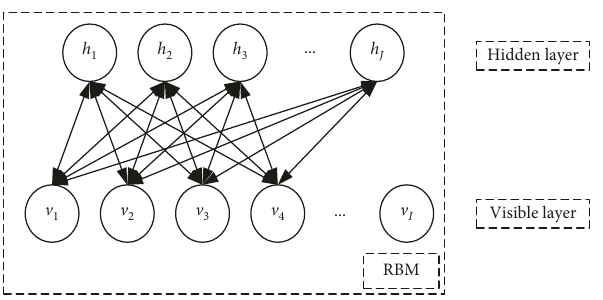
Figure 2: The structure of